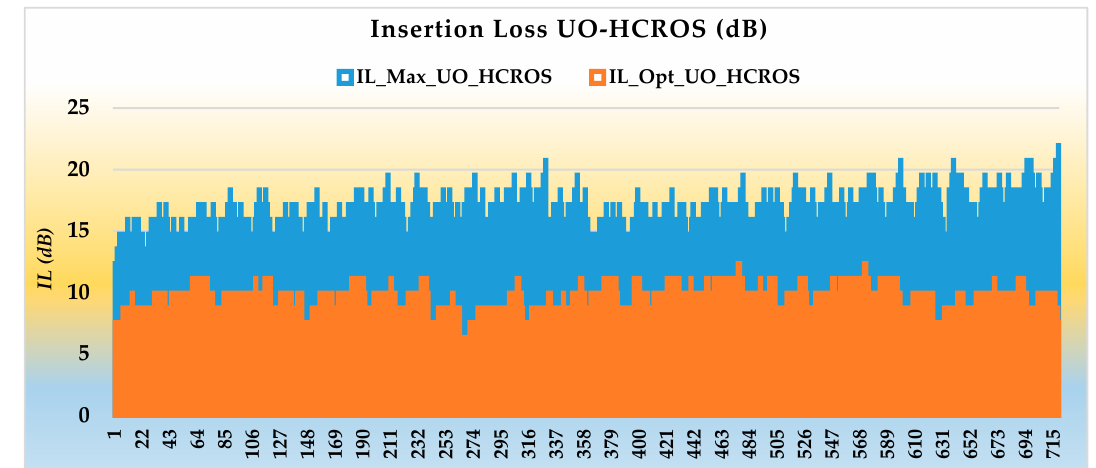
Figure 18. Insertion loss IL Max_UO_HCROS and IL Opt_UO_HCROS for all 720 I/O links in un-optimized HCROS.